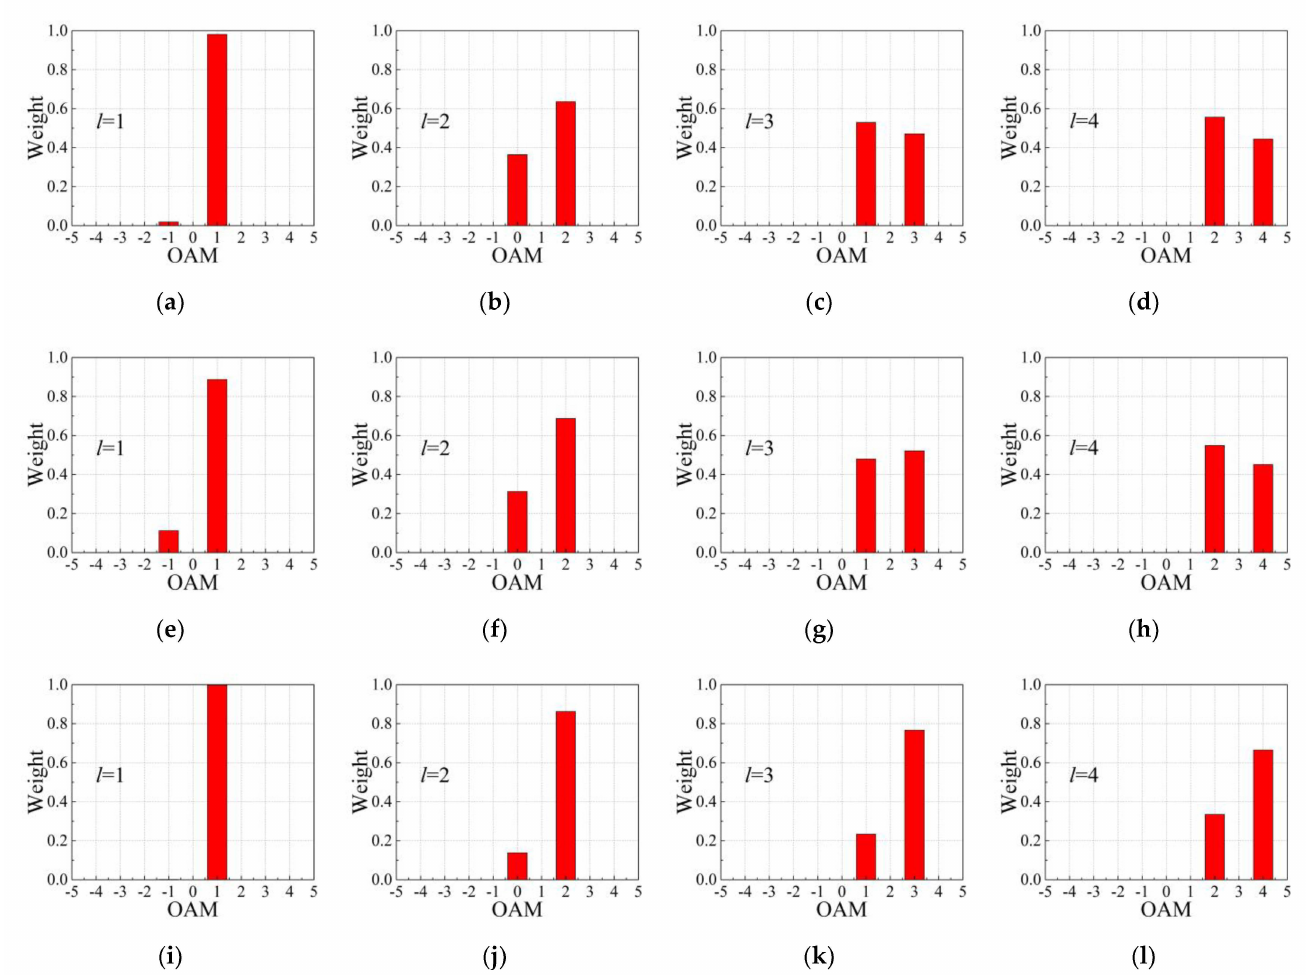
Figure 16. The spiral spectra of the scattering fields of right circular polarized Bessel–Gaussian vortex beams were scattered by a particle with different sizes and different complex refractive indices. The scatterer particle is a uniform and isotropic sphere. Radius a and complex refractive index m of the illuminated particle are: a = 0.5 µ m and m = 1.377 + 1.62 × 10 − 3 i in panels ( a – d ); a = 0.5 µ